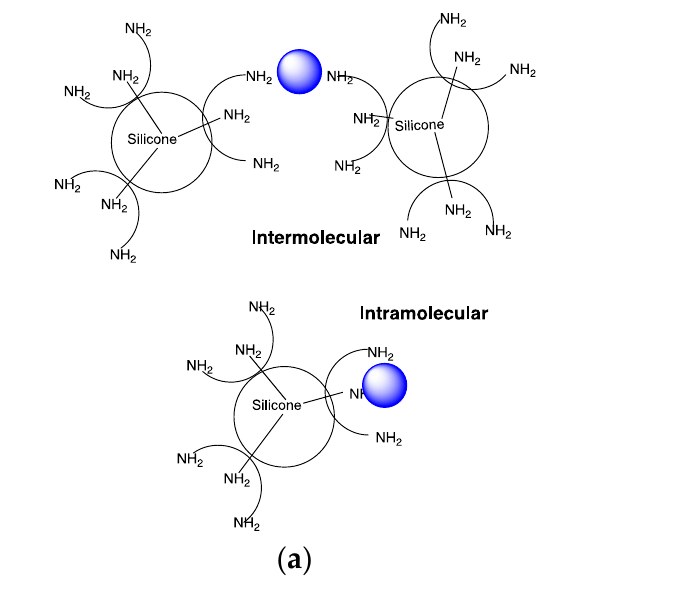
Figure 5. ( a ) Inter- vs. intramolecular chelation for N9 , the former leading to crosslinks. ( b ) Transfer of ions from chelated silicones to aqueous EDTA solution over 12 h.